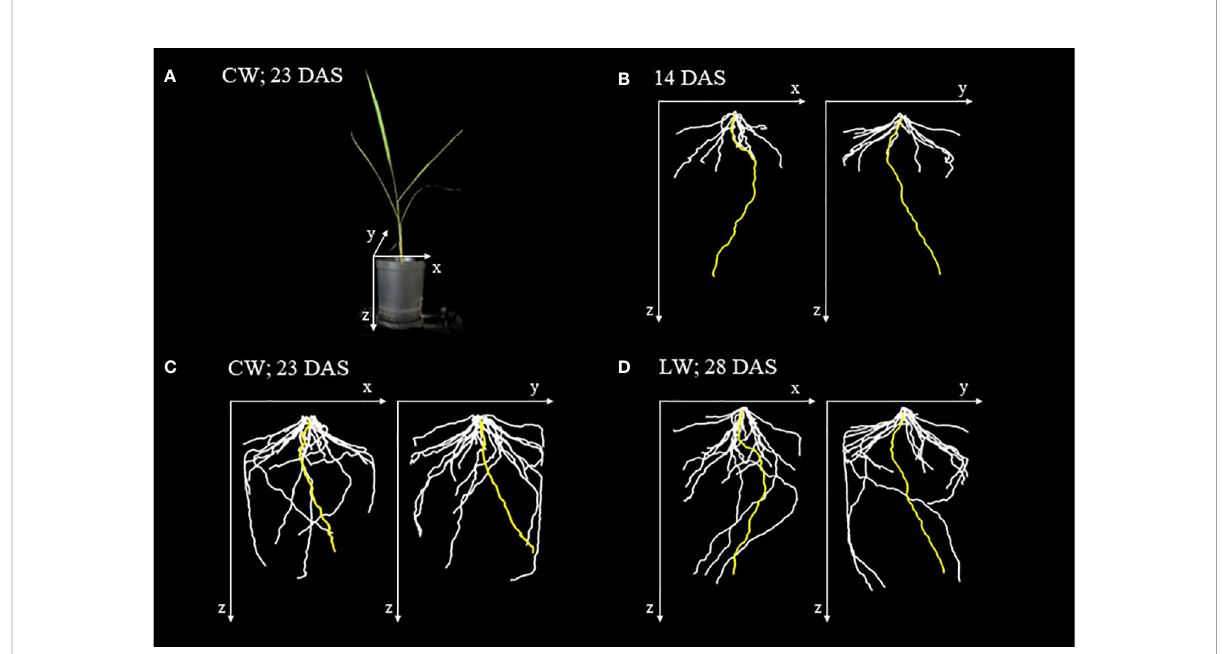
FIGURE 2 X-ray images of the root system architecture (RSA) of rice plant grown in a plastic pot. (A) Images of rice plant grown in a plastic pot 23 days after sowing (DAS) under control water content (CW). (B) RSA of rice plant 14 DAS based on 3D reconstructed image obtained from X-ray CT image. The yellow-, white-colored lines indicate seminal and crown roots, respectively. The x, y, and z axes correspond to the axes shown in (A) . (C) RSA of the rice plant under the CW at 23 DAS. (D) RSA of the rice plant under the low water content (LW) at 28 DAS. This is the same plant shown in (B)